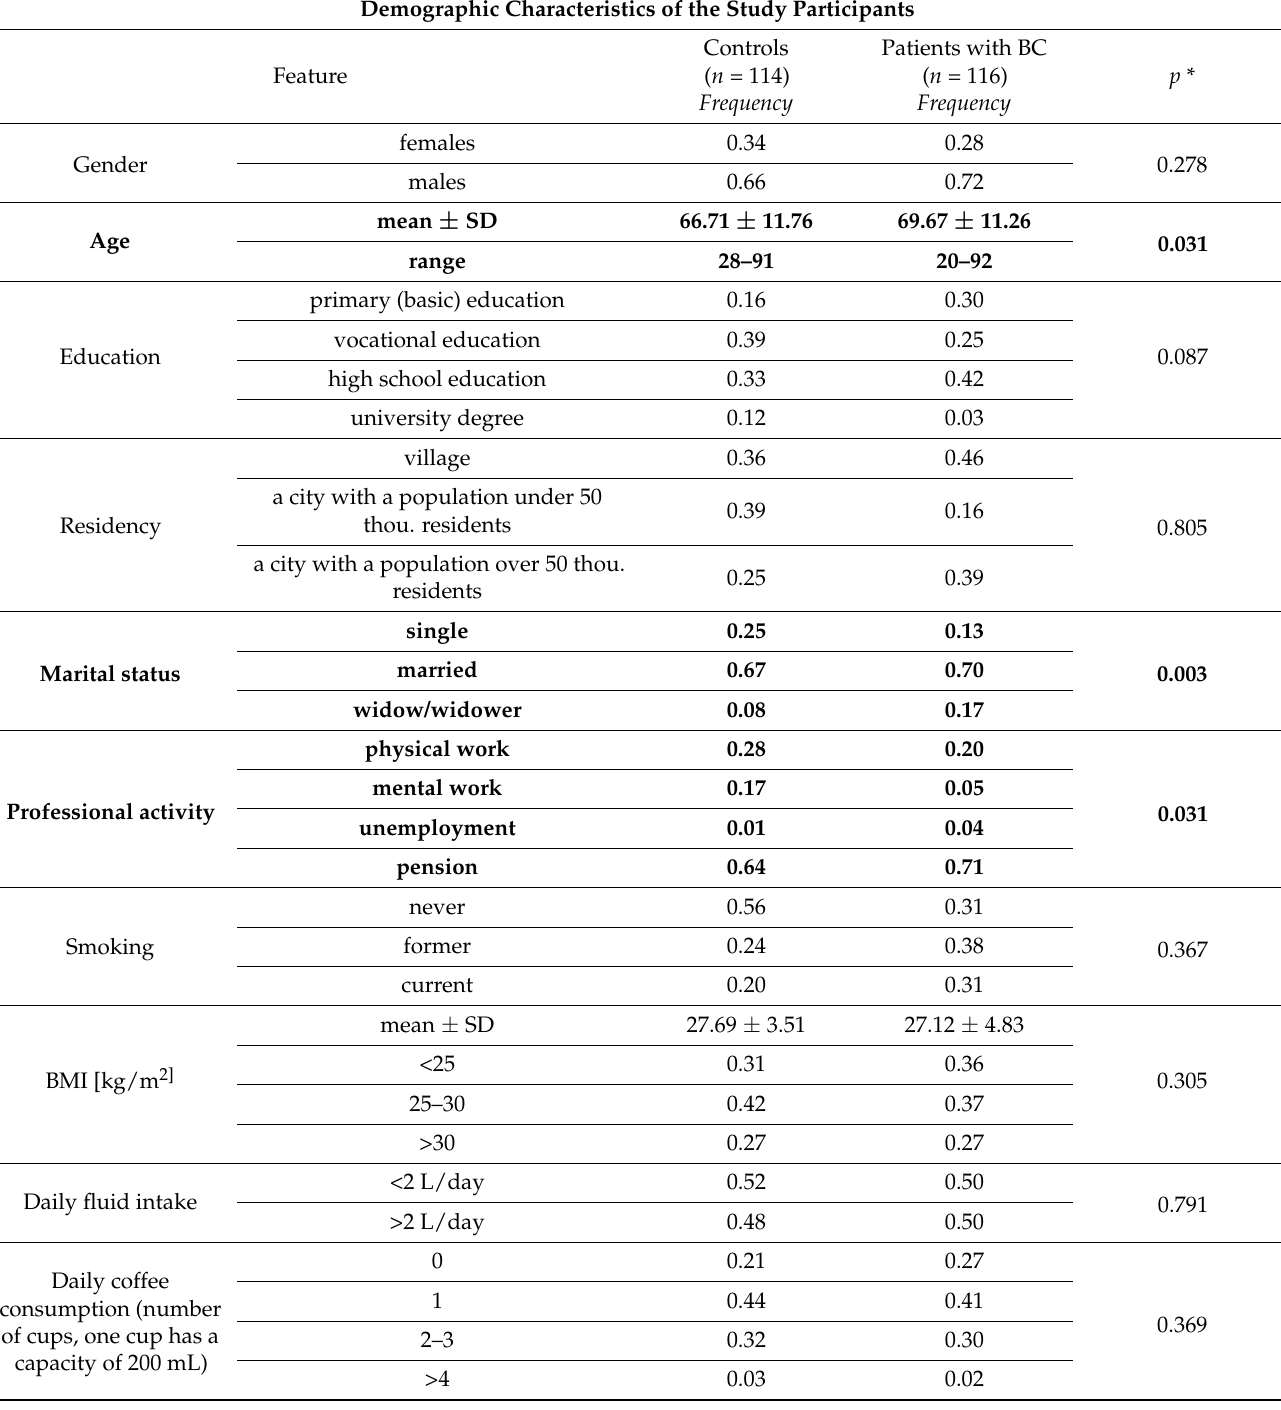
Table 1. Clinical demographic characteristics of study